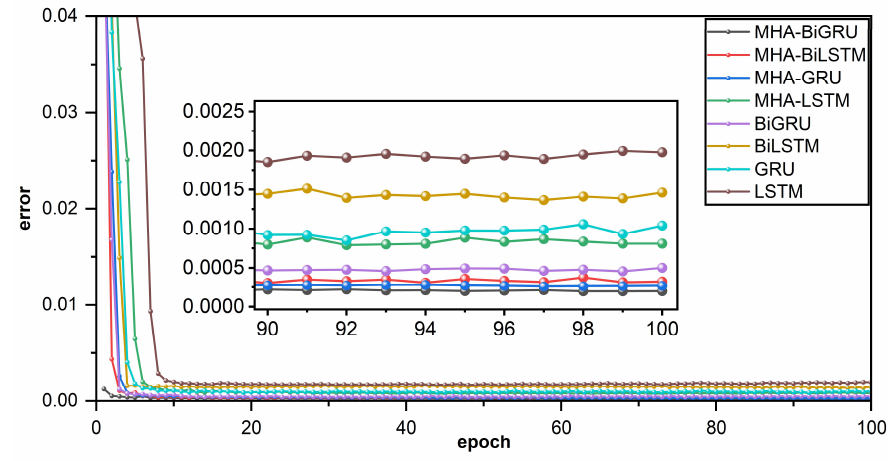
Figure 8. Loss value of overall comparative experiments.